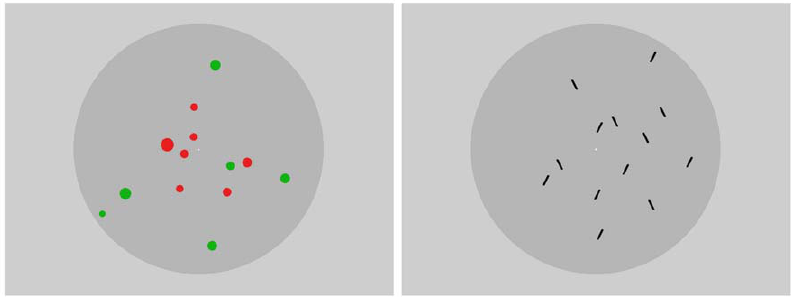
Figure 1. Stimulus configurations in the two experiments. Schematic view of stimulus configurations used in the numerosity discrimination experiment using color (left panel) or orientation (right panel) as a distinctive attribute. with the resolution 1024 6 769 pixels) with the help of a ViSaGe (Cambridge Research Systems Ltd.) stimulus generator. Every stimulus condition was replicated 100 times. Choice probability of the red circles was plotted as a function of the proportion of red elements N R in the total number of elements on the display N = N R + N G . Similarly in the orientation experiment, probability of the choice of the leftward tilted elements was measured as a function of the proportion of leftward tilted elements N (\) in the total number of elements on the display N=N (\) + N (/) .